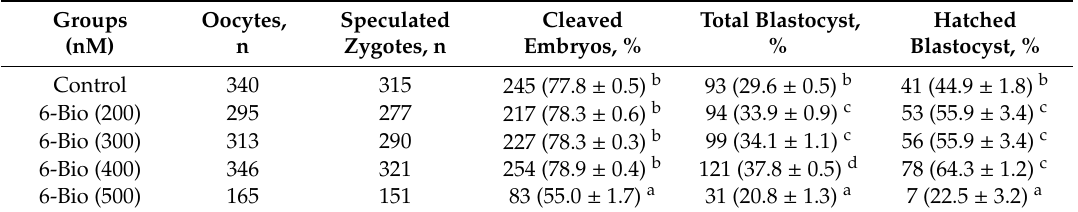
Table 1. Effect of concentration of Wnt agonist 6-Bio on bovine blastocyst (BL) development and hatching.